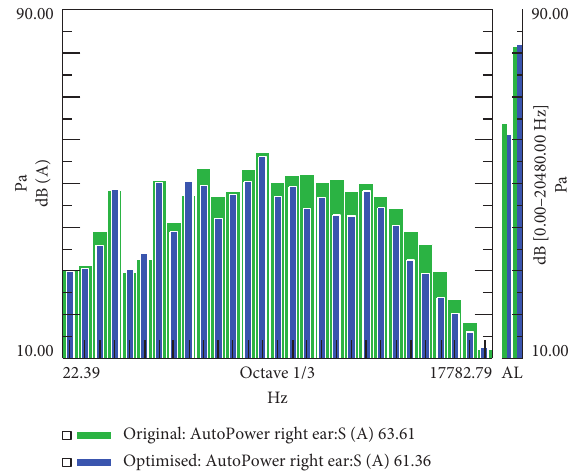
Figure 22: Comparison of right-ear noise experiment values of the cab before and after